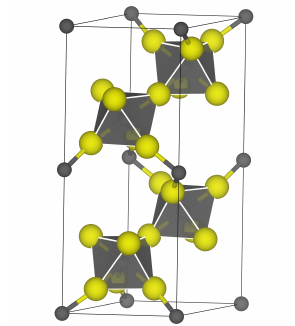
Figure 1. Representation of the hexagonal unit cell of α -AlF 3 with experimental lattice constants a = 4.931 Å and c = 12.466 Å. The grey circles indicate aluminum and the yellow circles fluoride atoms. The octahedral structure formed by the fluorides is highlighted by the grey transparent area. Grey = aluminum, yellow =